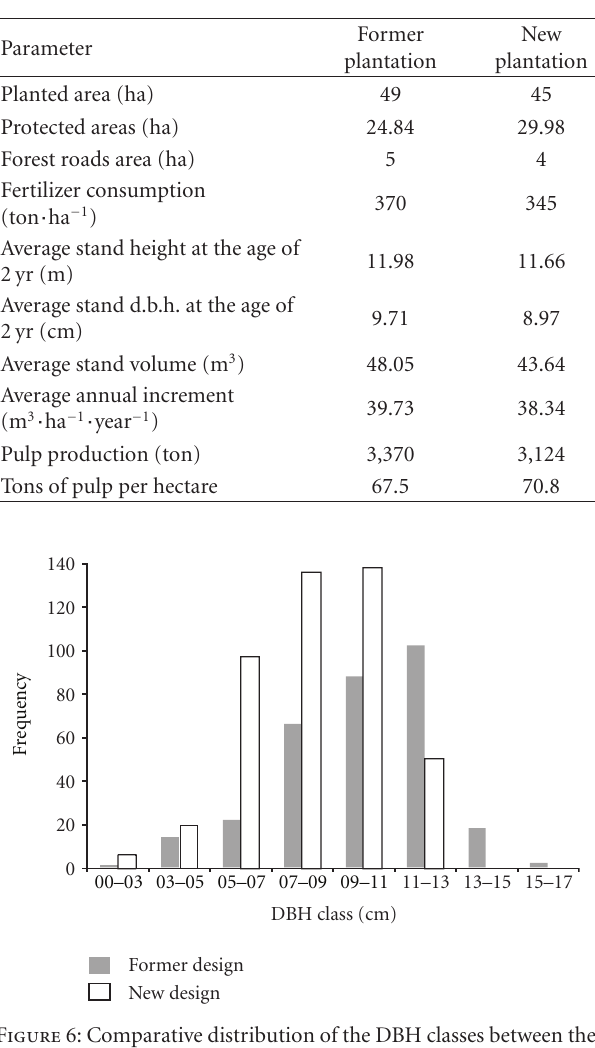
Table 2: Comparative values of the changes occurred in the exper- imental catchment, in terms of planted area, water conservation area, area of forest roads, fertilizer consumption, average stand height, DBH and volume, at the age of 2 years, and projected average annual increment of wood at the end of the rotation period (7 years), also based on the parameters measured at the age of 2 years, pulp production and tons of pulp per hectare, between the former plantation and the new plantation design.